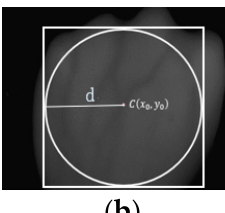
Figure 2. Dorsal hand vein images captured by two different devices. ( a ) Captured by No. 1 device; ( b ) captured by No. 2 device.